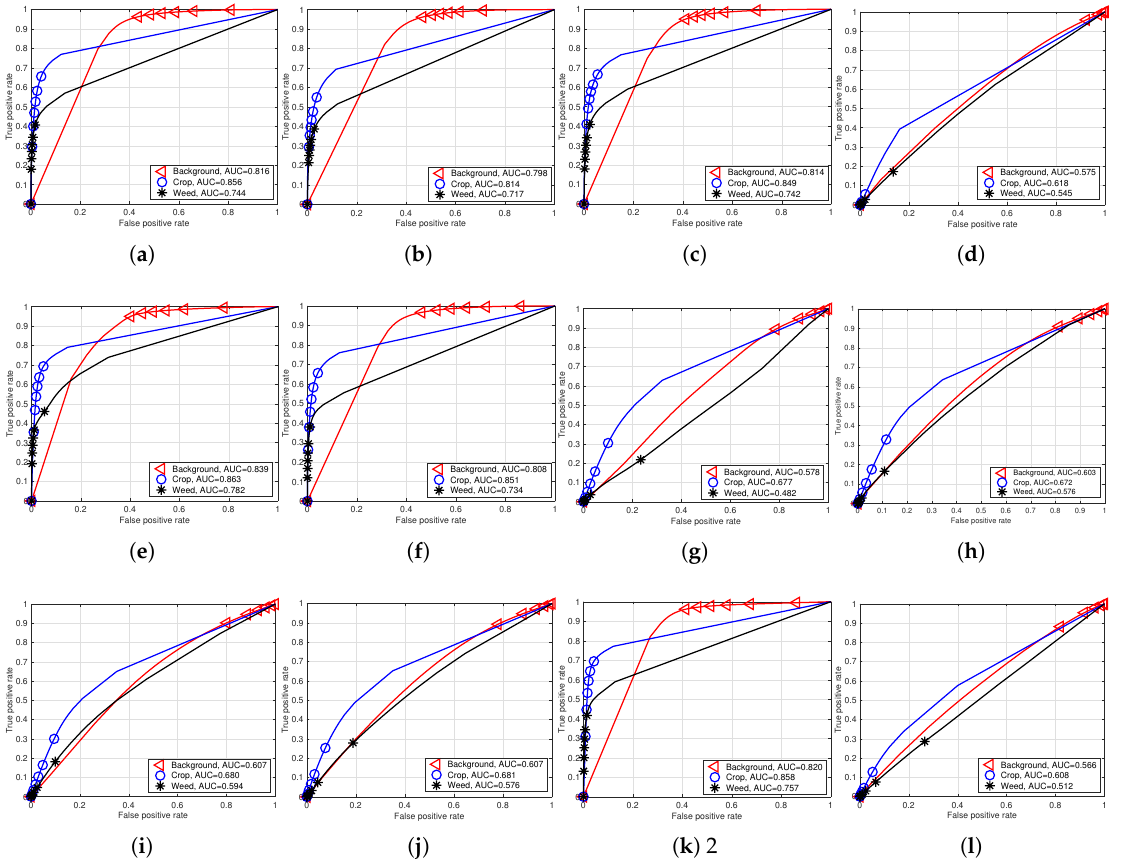
Figure 10. Performance curves of the RedEdge-M dataset models (Model 1–13). For improved visualization, note that we intentionally omit Model 11, which performs very similarly to Model 10.